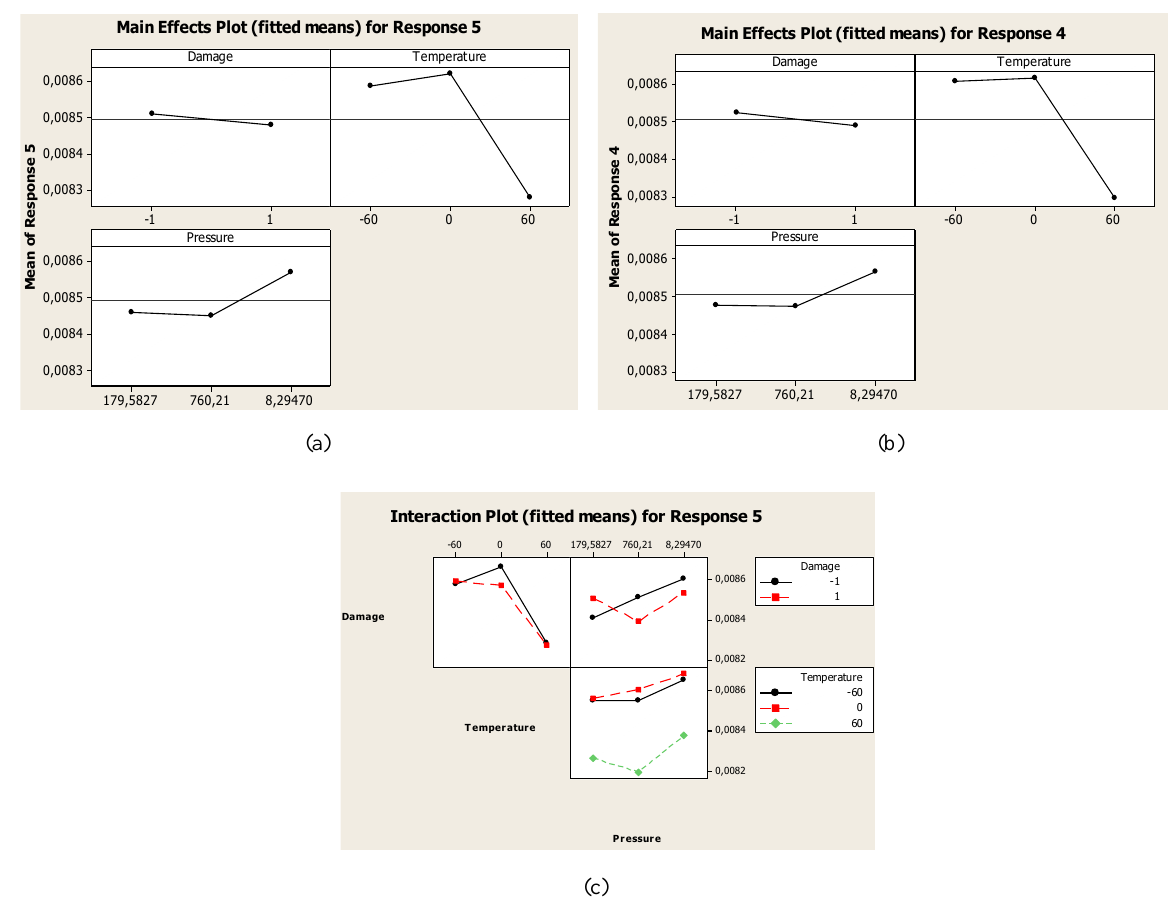
Fig. 13. Main effects of the factors (pressure and temperature): (a) Response #5; (b) Response #4; (c) Cross